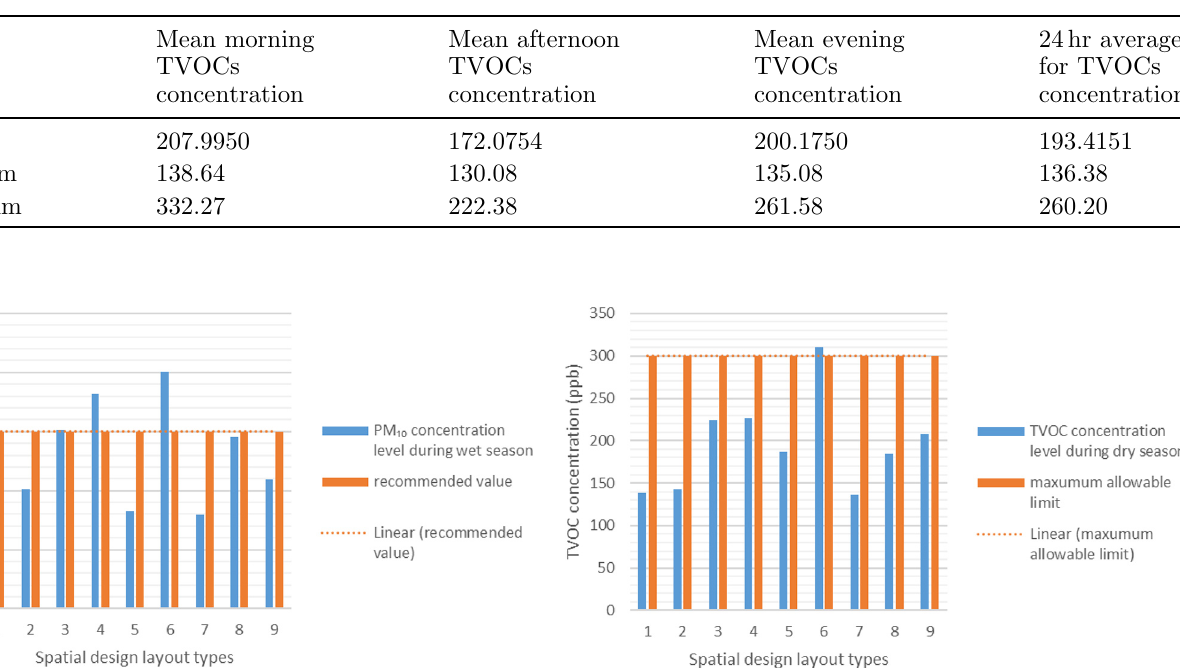
Table 9. Concentration levels of total volatile organic compounds during the wet season.